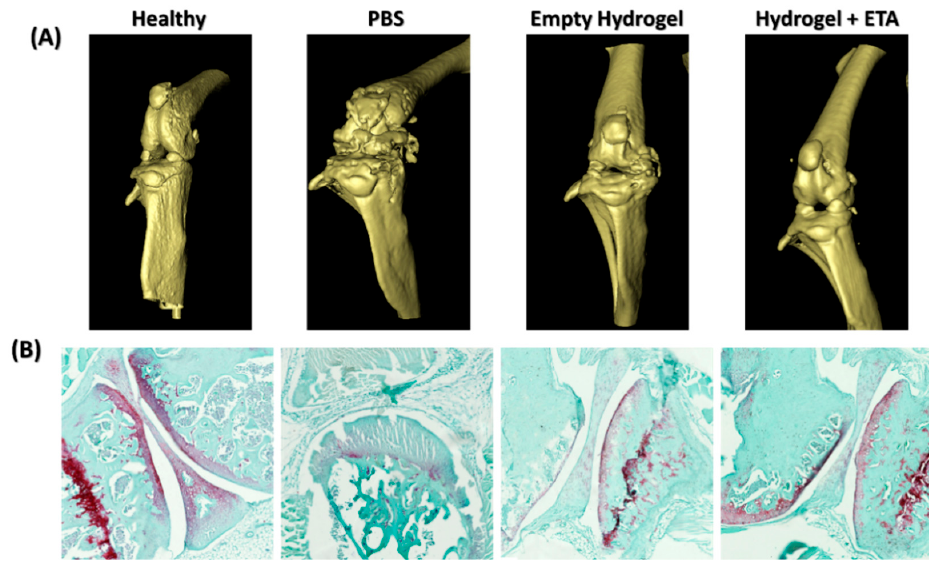
Figure 6. Representative mouse knee images in μ -CT and histological analysis ( A ) In vivo μ -CT scans of mouse knee joints showing a 3D view of the cartilage surface. From left to right healthy knee (negative control), OA knee with PBS injection (sham treatment/positive control), OA knee treated with empty hydrogel, and OA knee treated with ETA-loaded hydrogel. ( B ) Histological staining with Safranin O/Fast Green of sections from healthy, sham-treated, and hydrogel-treated mouse knees.